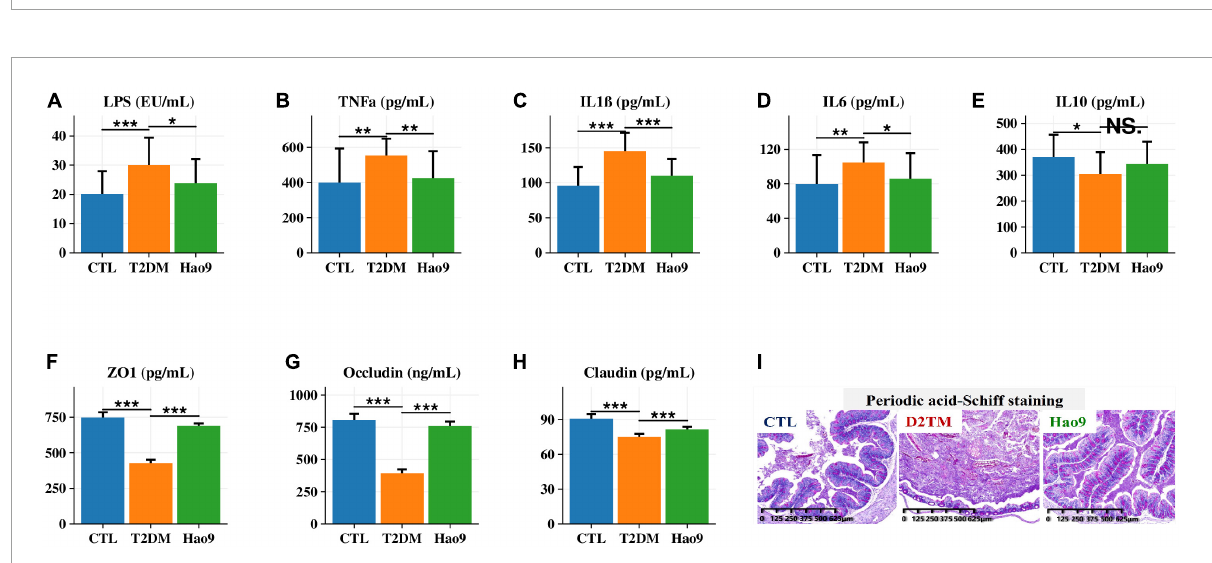
FIGURE3 Effect of Hao9 on serum inflammatory factors and intestinal barrier. Effect of Hao9 on serum lipopolysaccharide (LPS) (A) , tumor necrosis factor alpha (TNF α ) (B) , interleukin-1 β (IL1 β ) (C) , IL6 (D) , and IL10 (E) . Effect of Hao9 on colonic zonula occludens (ZO-1) (F) , occludin (G) , and claudin (H) . Periodic acid-Schiff staining (I) showed the effect of Hao9 on histopathological changes in the colon of type 2 diabetes mellitus (T2DM) mice. * p < 0.05, ** p < 0.01 and *** p < 0.001 vs. T2DM group. In bar plots, we used mean ± standard deviation (SD) to describe differences between